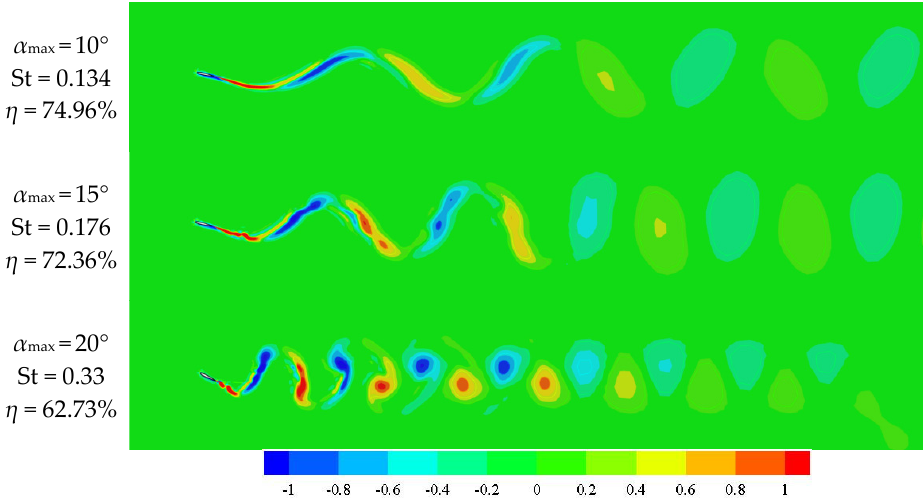
Figure 9. Vorticity filed at some higher efficiency conditions.